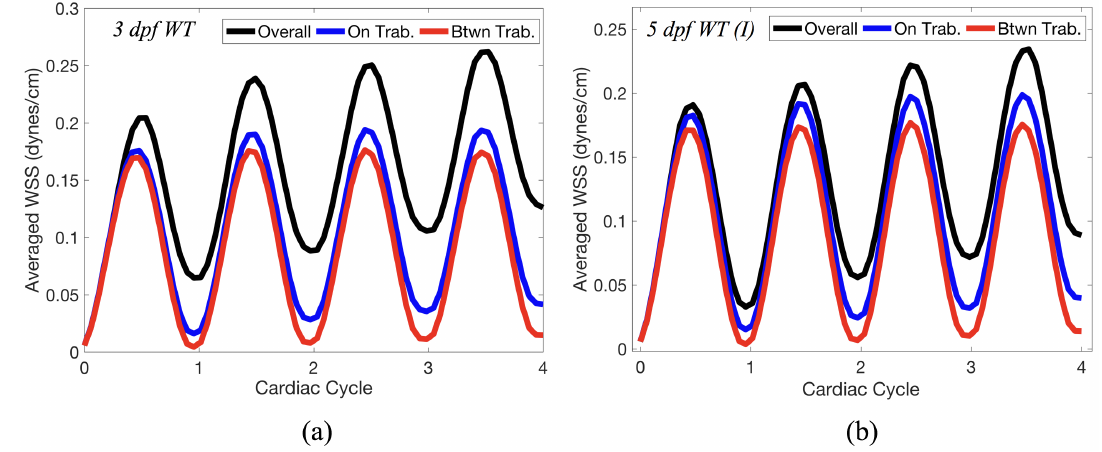
Figure 14. Plot giving the spatially-averaged magnitude of WSS over the trabeculae, the intertrabecular regions, and the entire ventricle during the first 4 pulsation cardiac cycles for the 3 dpf WT ( a ) and 5 dpf WT (I) ( b ) ZF for Re = 1. In both cases, intertrabecular regions experience less WSS than the trabeculae